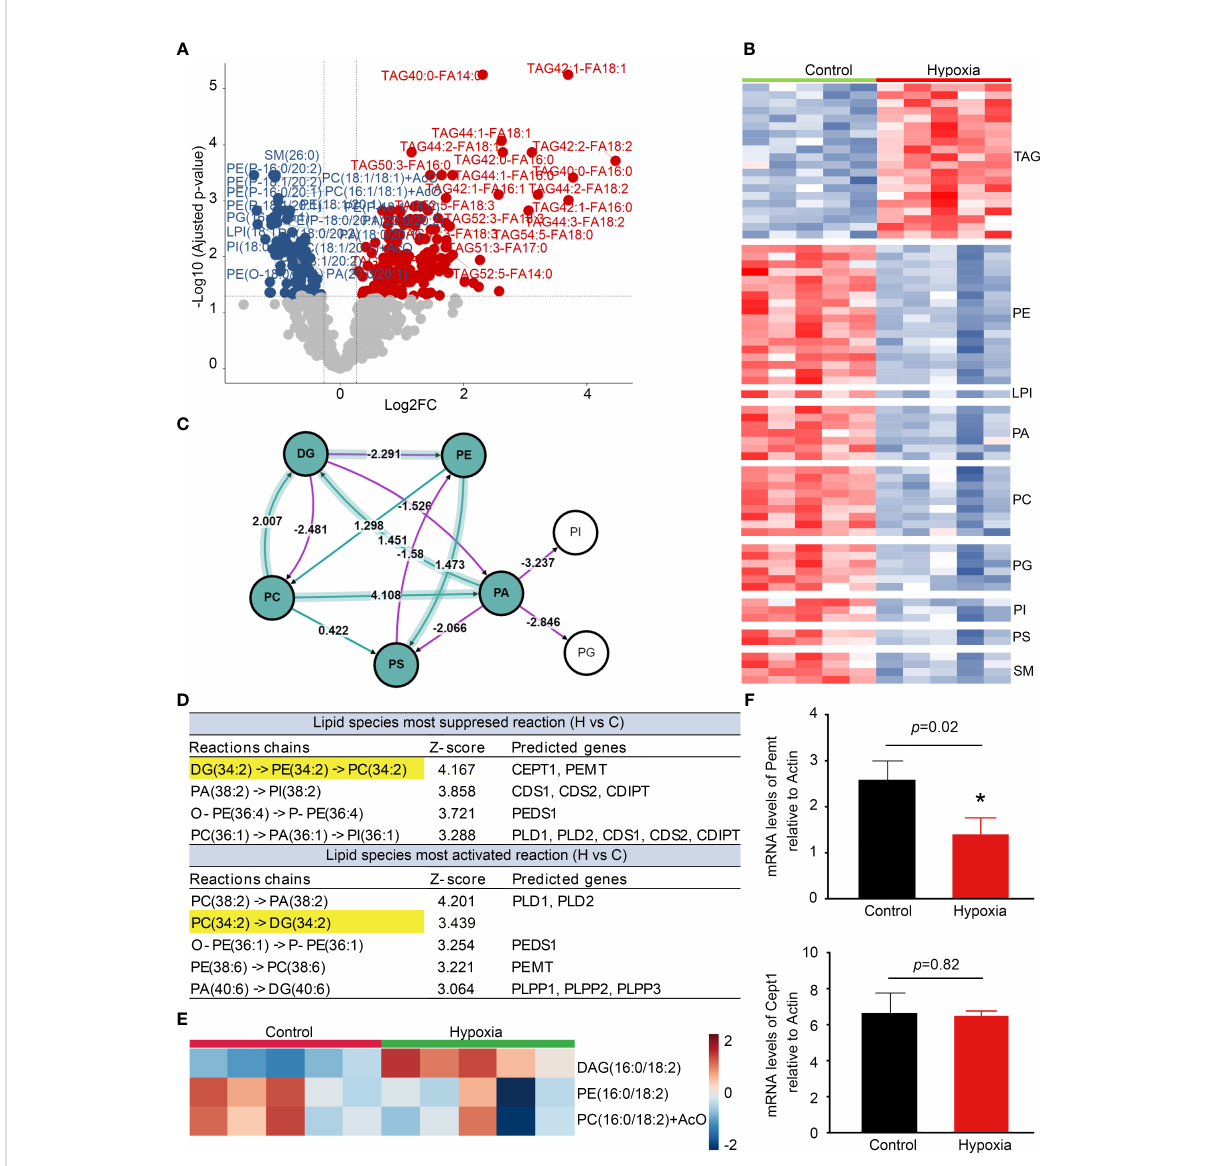
FIGURE 6 Lipidomics reveals microglia activation with triacylglycerol (TAG) accumulation. (A) The volcano plot shows the comparison of cell lipids between control and hypoxia. The blue and red dots indicate lipids downregulated and upregulated under hypoxia compared with control, respectively (fold change > 1.2, p < 0.05). (B) Heatmap representation of differentially abundance lipids. (C) Analysis of differential lipid pathway induced by hypoxia stress using BioPAN. (D) Lipid species most activated and suppressed in the hypoxia group compared with control. (E) Heatmap representation of diacylglycerol (DAG) -16:0/18:2, phosphatidylethanolamine (PE) -16:0/18:2, and phosphatidylcholines (PC) -16:0/ 18:2 +AcO (ant colony optimization) in the hypoxia and control groups. (F) Counts-per-million (CMP) values of Pemt and Cept1 expression in the control and hypoxia groups. *p <